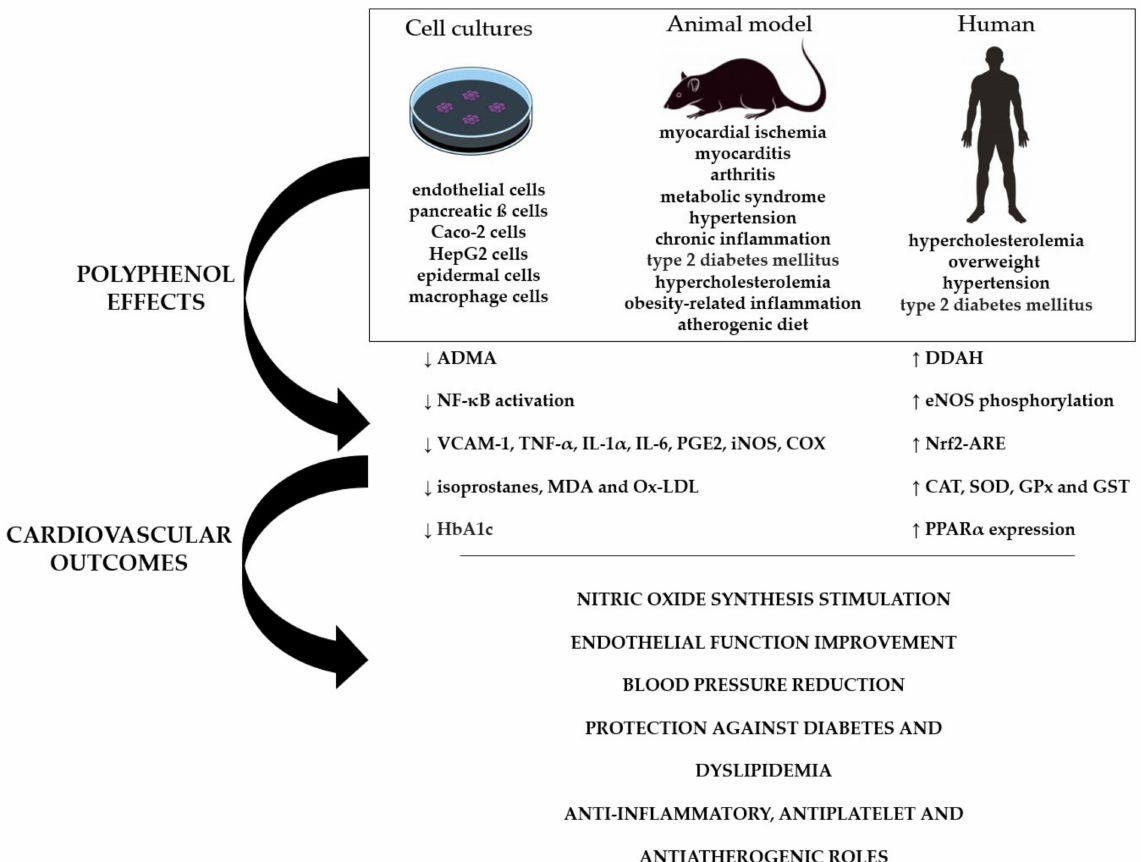
Figure 1. Protective role of polyphenols in different inflammatory and oxidative pathways in cells, animals, and humans that protect and improve the cardiovascular